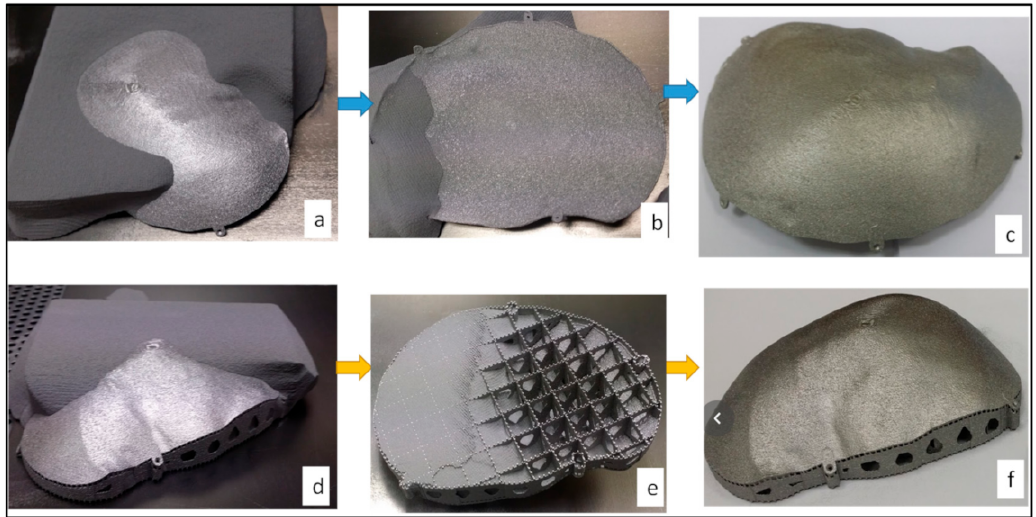
Figure 6. The EBM produced customized cranial implant without supports ( a – c ) and implant with support structures ( d – f ).